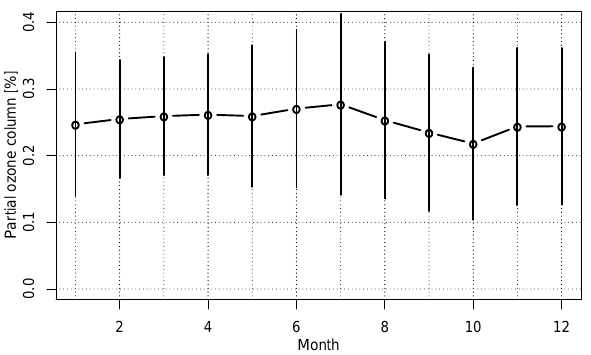
Figure 10. Monthly mean percentage contribution of the partial ozone column integrated from the Davos to Arosa altitudes based on the NABEL surface ozone measurements to the total column. The bars correspond to two